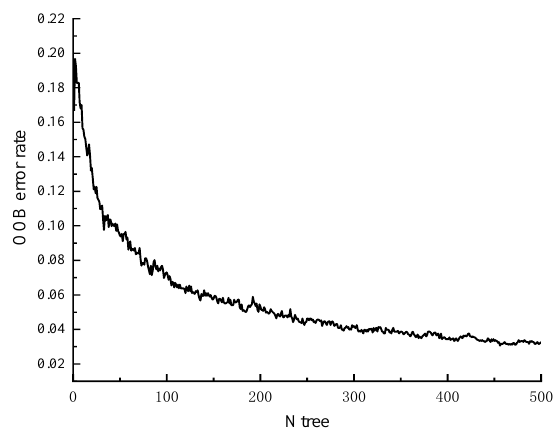
Figure 6. Relationship between OOB error rate and number of Ntree.